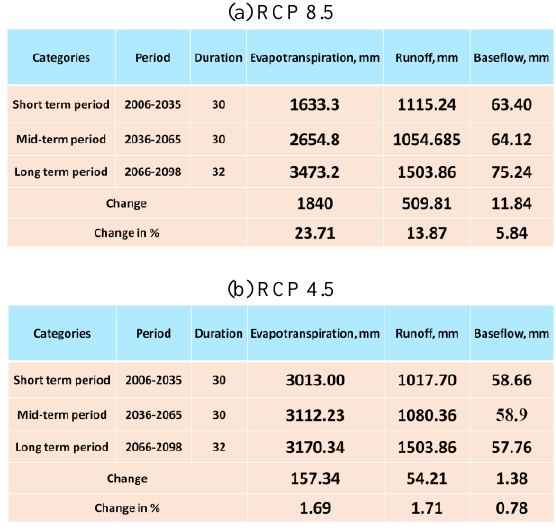
Table 2. The change in water balance under each